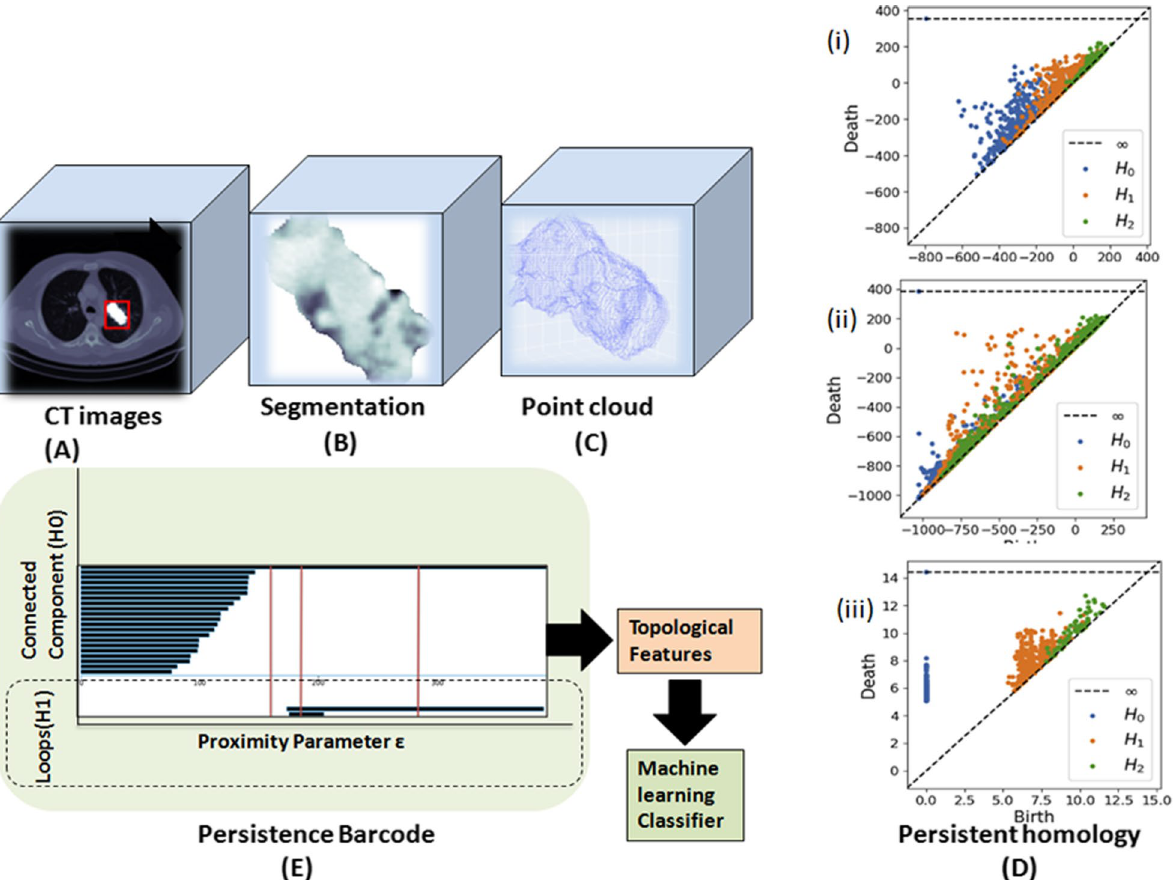
Fig. 5 Numerous ways to compute PH from radiographic images. a An example 3D slice from a CT scan showing a lung tumor. The red box shows the lung tumor. The segmented tumor pixels are highlighted in white to distinguish them from their CT pixel values, which may be better seen in the following two images. b The same slice of the CT scan image only showing the tumor pixels that have been segmented. c A point cloud illustrating the tumor surface by stacking the tumor contours of all the 2D CT scan slices. d (i) Persistence diagrams derived from sublevel filtration of a 3D tumor image; image b showing a 2D slice. Three persistence diagrams are displayed. Each of the three dimensions of the topological hole under consideration has an unique diagram ( H 0/0 -dim: connected components, H 1/1 -dim: cycles, and H 2/2 -dim: voids). (ii) The persistence diagrams, of which a 2D slice is shown in b , were generated by sublevel filtering the 3D tumor image with adjacent boundary box pixels. (iii) The lightly drawn persistence diagrams for the Vietoris–Rips filtering of the tumor surface-representing point cloud in c . e This is the persistent barcode extracted from the PH (H 0/0 -dim: connected components, H 1/1 -dim: